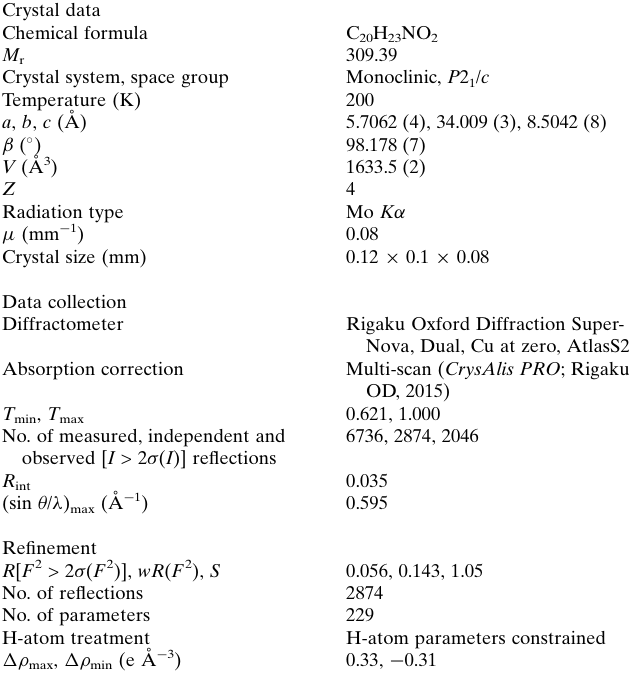
Table 2 Experimental details. Crystal data Chemical